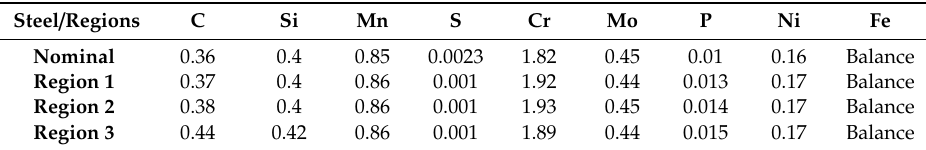
Table 2. Chemical composition of the investigated steel and regions (wt.%).